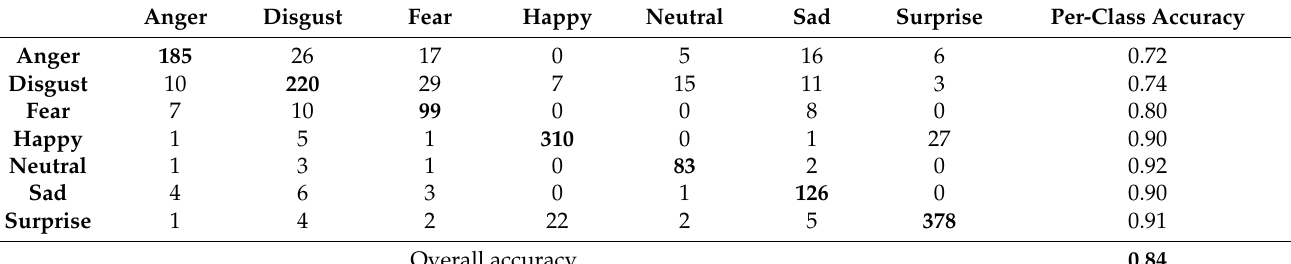
Table 4. Cross-validation over CK+ dataset.